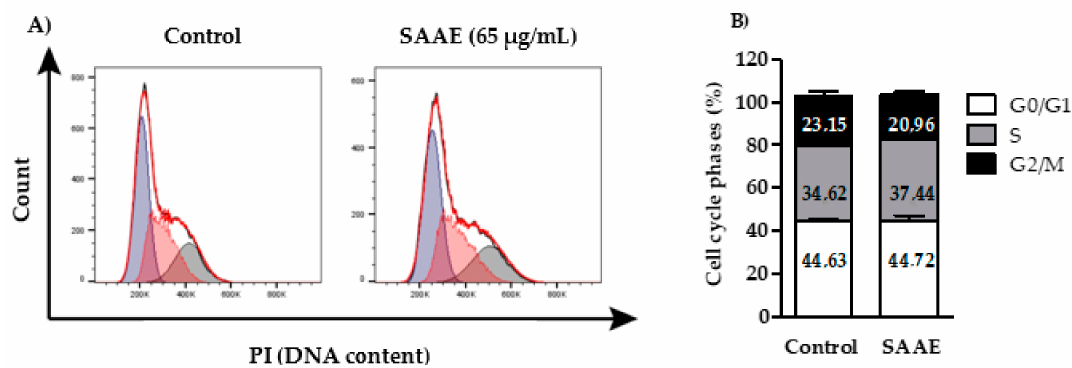
Figure 8. ( A ) Histogram and ( B ) graphical representation of the percentages of cells in the G0/G1, S and G2/M phases after treatment with the SAAE (65 µ g/mL) for 24 h. Data are expressed as the mean ± SEM ( n = 3) in duplicates.